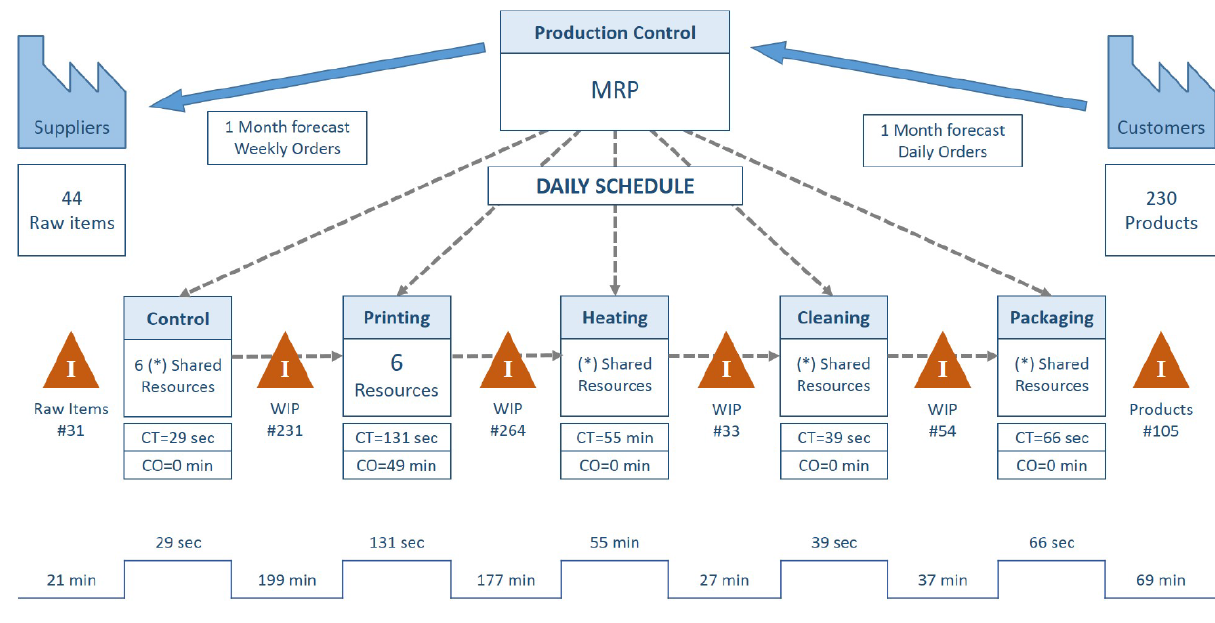
Figure 6. VSM Design Point: #5 CELLMFG Map